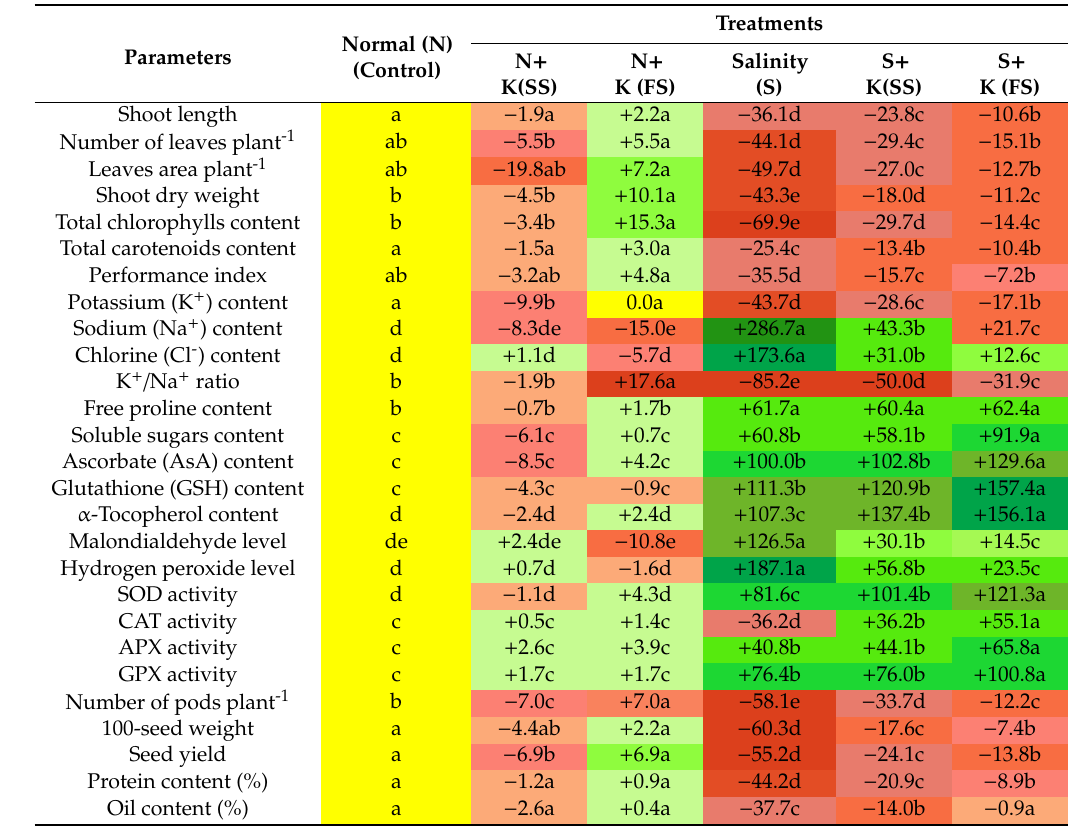
Table 2. Changes (%) in plant growth, physiology, biochemistry and productivity, relative to the control in soybean plants under normal (EC = 2.68 dS m − 1 ) and saline (EC = 7.46 dS m − 1 ) conditions. Three-color scale heatmap: yellow as the midpoint of control and parameters with insignificant values compared to control, red for changes below control values and green for changes over control